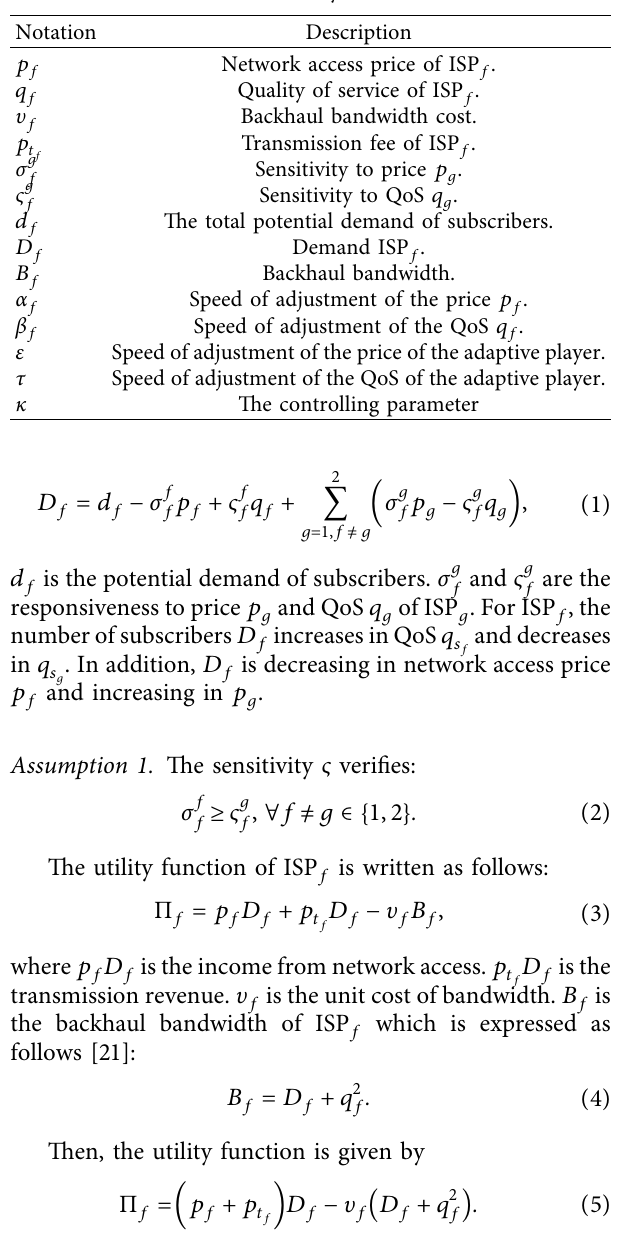
Table 1: Summary of